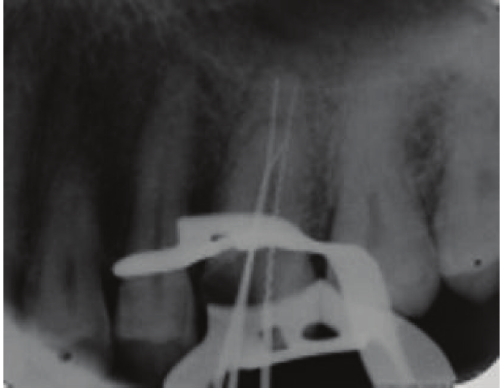
Figure 3: Pulp chamber floor after root canal preparation.